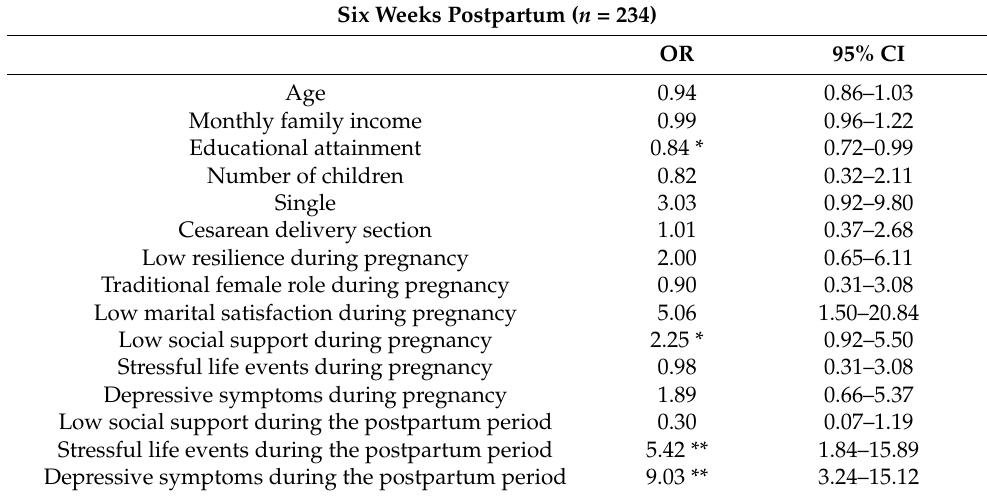
Table 5. Multivariate logistic regression model of six weeks postpartum anxiety